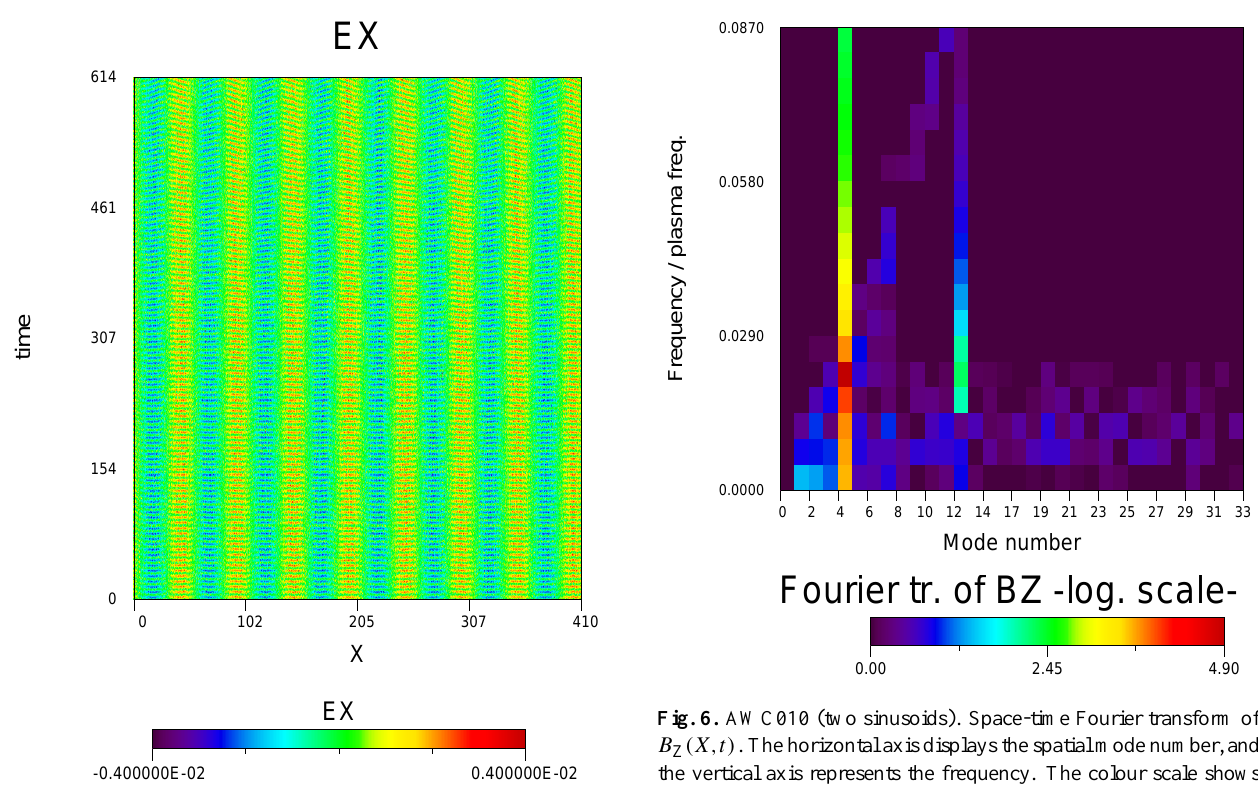
Fig. 5. AWC010 (two sinusoids). Temporal stack plot of the longi- tudinal electric field E X (X,t) .